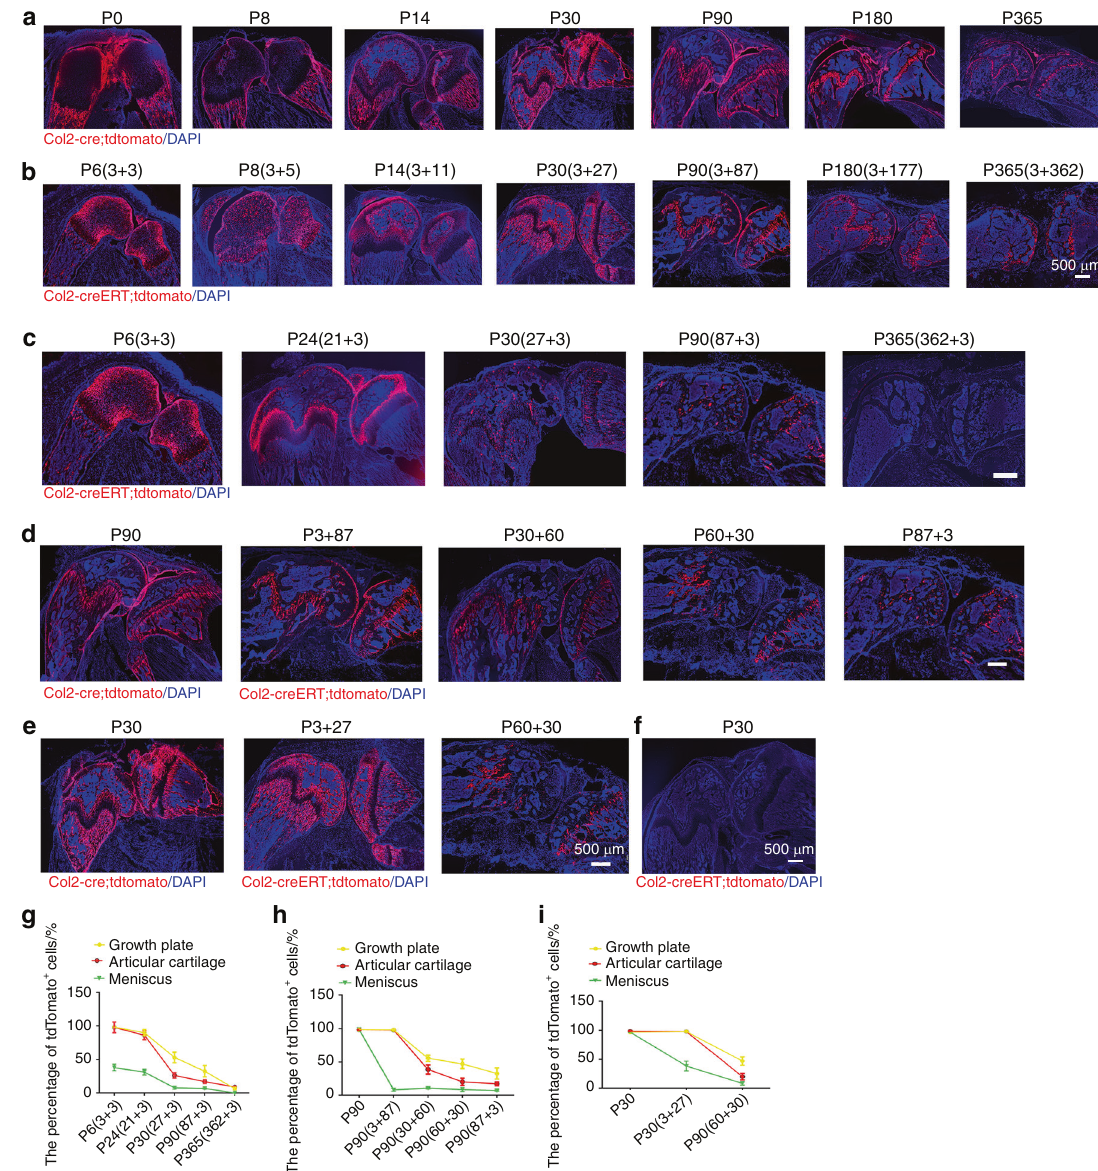
Fig. 5 Spatial distribution of embryonic and postnatal Col2 + cells in mouse long bones and knee. a Representative images from the lineage tracing of embryonic Col2 + cells in long bones and knee joints at different time points (P0, P8, P14, P30, P90, P180 and P365). b Representative images from the lineage tracing of postnatal Col2 + cells in long bones and knee joints at different time points (P6, P8, P14, P30, P90, P180 and P365). This analysis was performed by injecting 75 mg·kg − 1 tamoxifen into P3 mice. To better present the data, the information for the Col2-creERT;tdTomato mice in each fi gure is presented as the harvest time (tamoxifen injection date + tracing time period)., e.g., P6 (3 + 3) means that the harvest date of Col2-creERT;tdTomato mice is P6, that tamoxifen was injected at P3 and that tracing was performed for three days. Because all Col2 + cells were activated starting from the embryonic stage in Col2-cre;tdTomato mice, we included only the date for the harvesting of mouse samples. For example, P8 means that the harvest date for the Col2-cre; tdTomato mice was P8. c Representative images from the lineage tracing of postnatal Col2 + cells in long bones and knee joints activated at different time points (P3, P21, P27, P87, and P362). Tamoxifen (75 mg·kg − 1 ) was injected into mice at the indicated time points. d Representative images from the lineage tracing of Col2 + cells in long bones and knee joints at P90 after activation at different time points (embryonic stage, P3, P30, P60 and P87). e Representative images from the lineage tracing of Col2 + cells in the long bones and knee joints of mice at P30 after activation at the indicated time points (embryonic stage, P3, and P60). This analysis was performed by the injection of 75 mg·kg − 1 tamoxifen into Col2-creERT;tdTomato mice at different time points. f Representative images of the long bones and knee joint of Col2-creERT;tdTomato mice at P30. This analysis was performed by the injection of 75 mg·kg − 1 vehicle into Col2-creERT; tdTomato mice at P3. g Quantitative measurements of the percentage of tdTomato + cells with respect to the total cells in ( c ) ( n = 6 mice per condition; three independent experiments). The data are presented as the means ± s.ds. h Quantitative measurements of the percentage of tdTomato + cells with respect to the total cells in ( d ) ( n = 6 mice per condition; three independent experiments). The data are presented as the means ± s.ds. i Quantitative measurements of the percentage of tdTomato + cells with respect to total cells in ( e ) ( n = 6 mice per condition; three independent experiments). The data are presented as the means ± s.ds. At least 1 000 cells of each sample were measured. The statistical signi fi cance was determined by one-way ANOVA and Student ’ s t test. * P < 0.05, ** P < 0.01, *** P < 0.000 1, NS not statistically signi fi